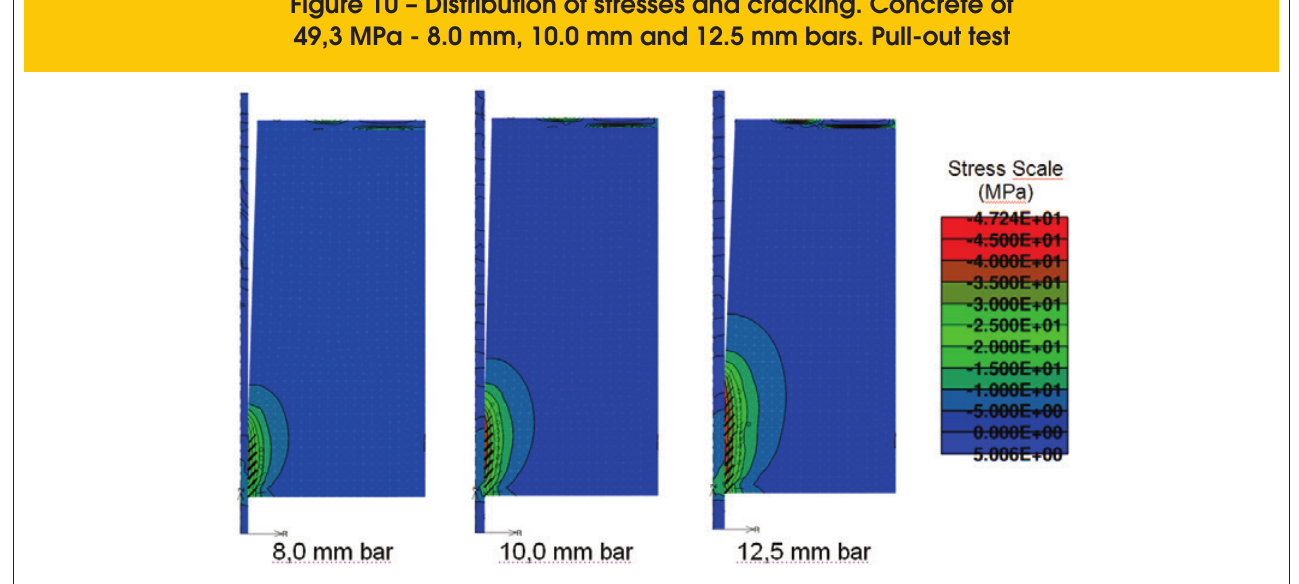
Figure 10 – Distribution of stresses and cracking. Concrete